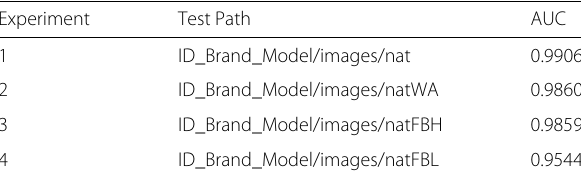
Table 2 Performance of image source identification in growing difficulty scenarios